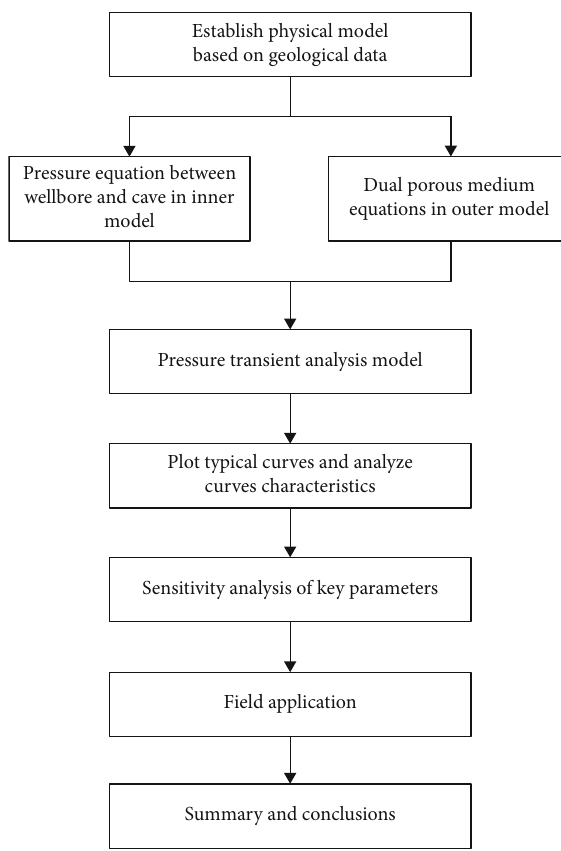
Figure 2: General sketch of the problem under